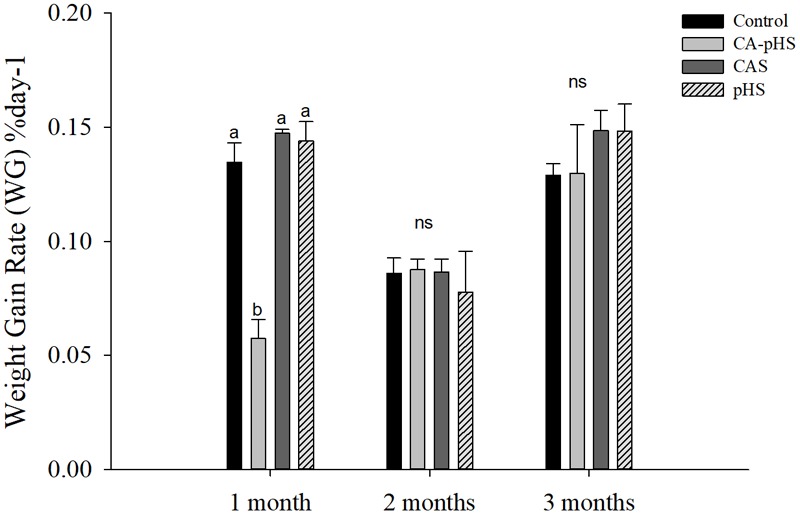
juvenile of S. constricta body weight gain rate in the long-term toxicity test. Bars (mean ± SE, n = 3) with different letters denote significant differences (p < 0.05) among the four groups in each month. The letters “ns” indicate insignificant difference among the four groups in each month.